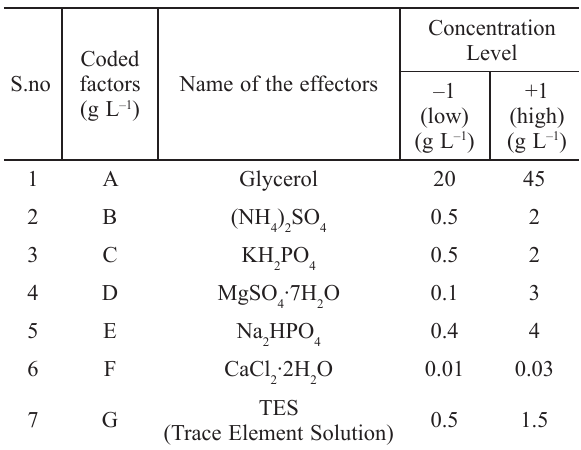
Table 1 – Concentration ranges of effectors of the medium recipe for Plackett-Burman Optimization protocol